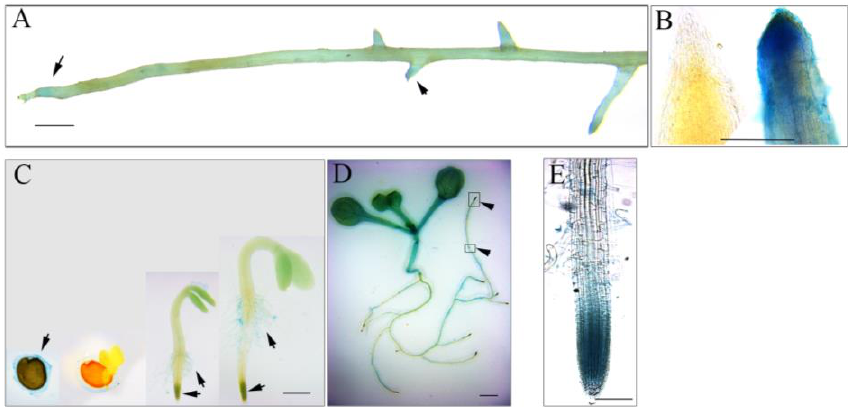
Figure 2. Tissue distribution of AhmTERF1 gene expression. ( A ): GUS staining of pAhmTERF1:GUS hairy roots. Scale bar: 0.5 cm. ( B ): Root tips of hairy roots (Left: Control hariy root; Right: